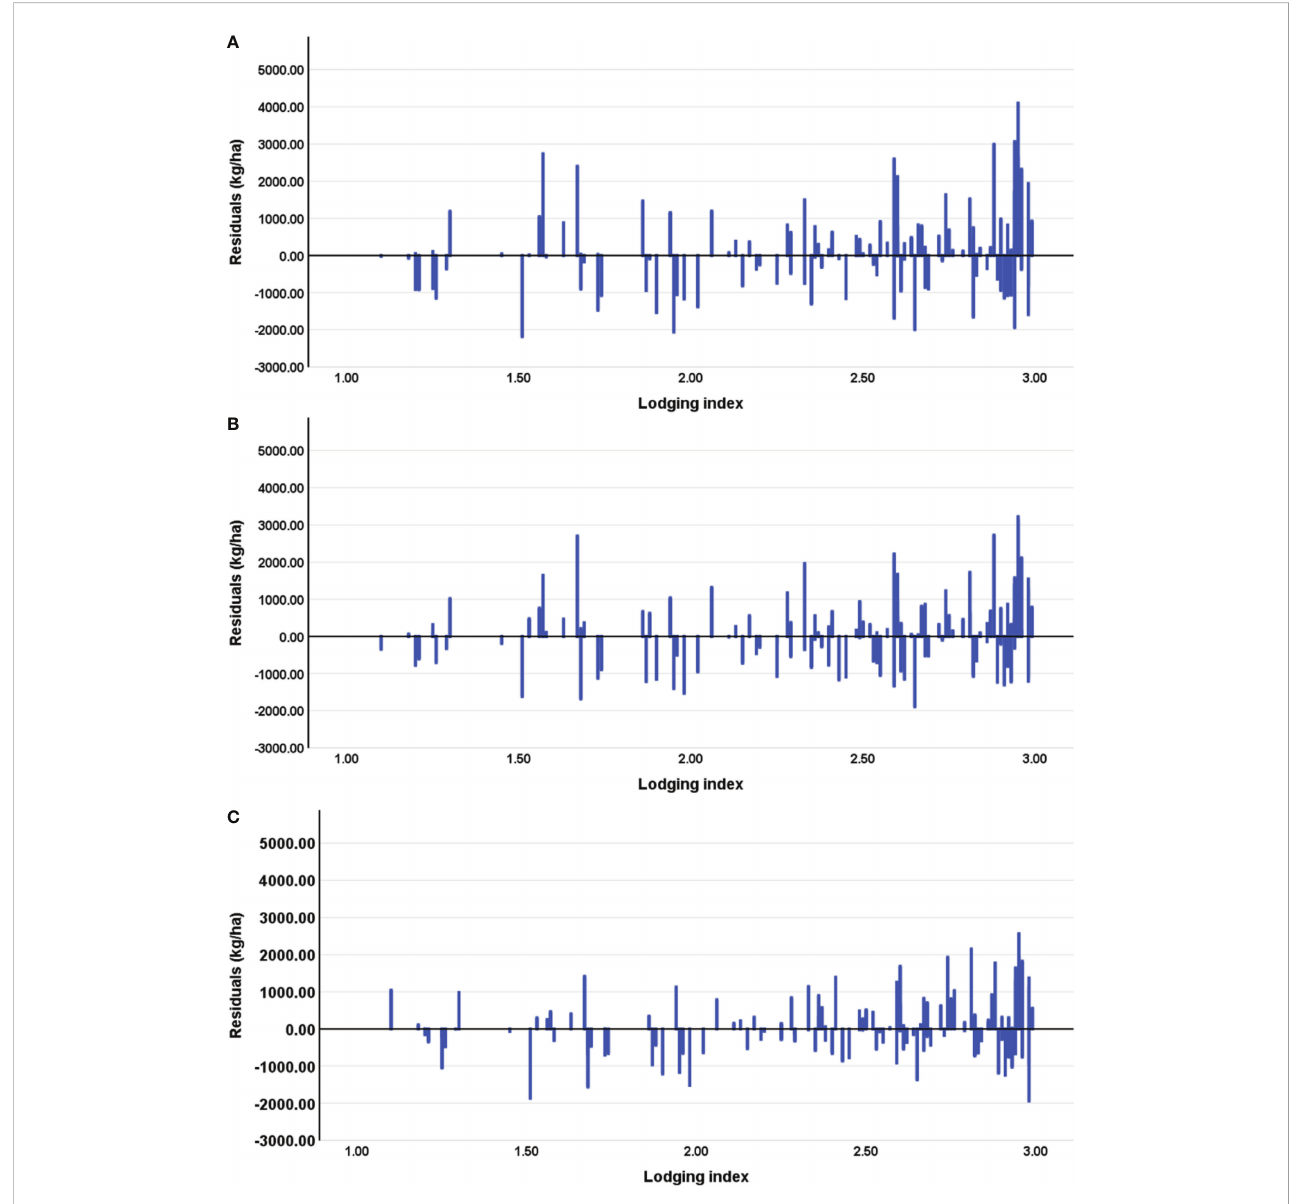
FIGURE 10 Residuals of yields estimated without considering the lodging index at the (A) tasseling stage (VT), (B) milking stage (R3), and (C) denting stage